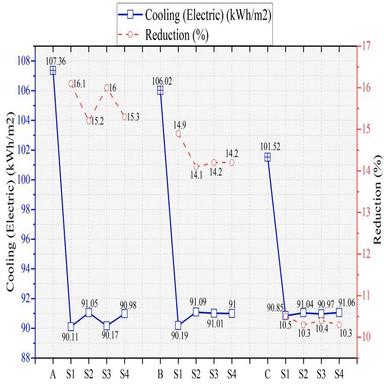
The comparison of the annual cooling consumption and reduction percentages of the existing façade finishes and their proposed solutions.